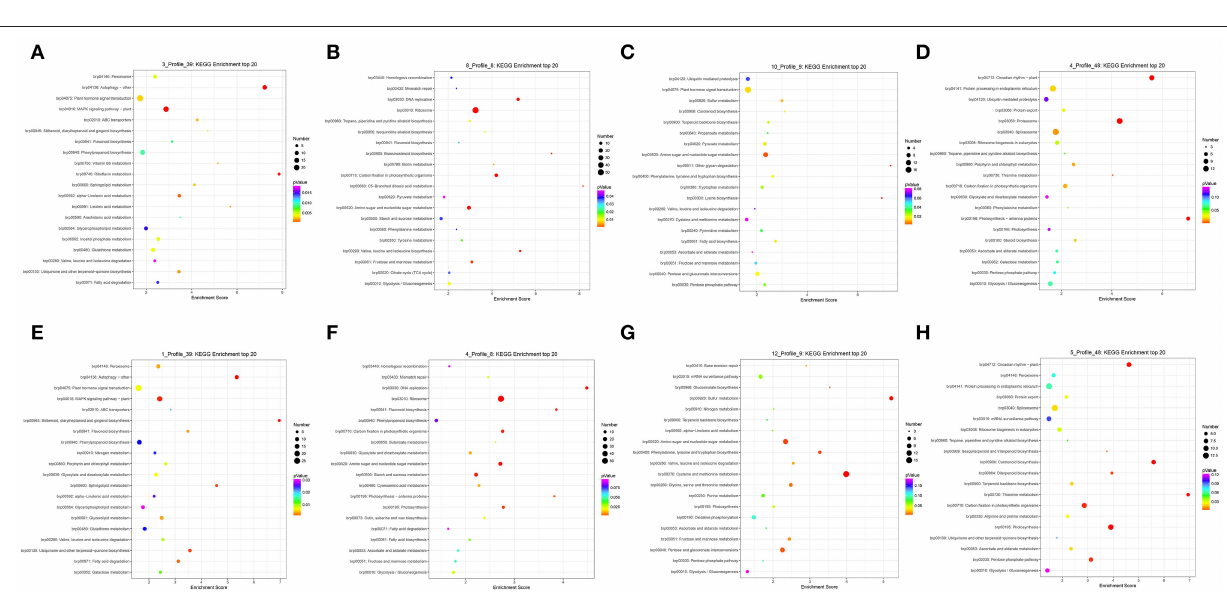
FIGURE 7 | Top 20 of the KEGG pathway enrichment of four representative expression patterns that may be candidate overwintering memory genes in (A–D) Longyou-7 (L7) and (E–H) Tianyou-4